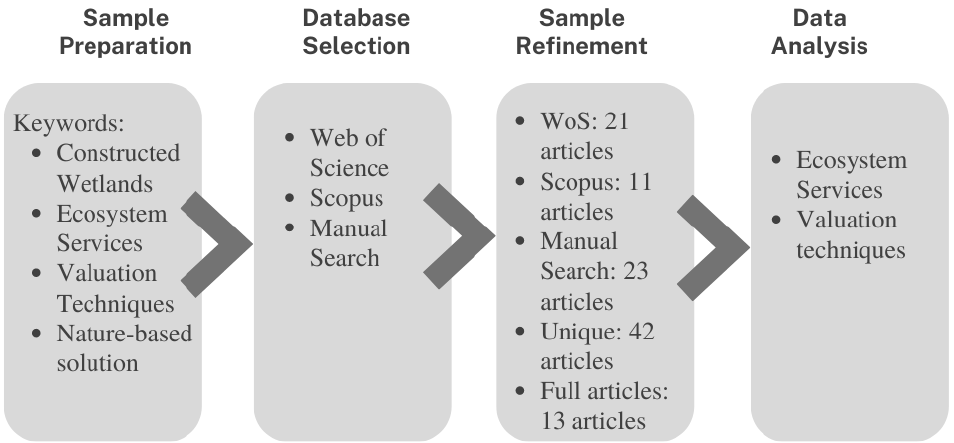
Figure 1. Systematic framework for a review of the literature.